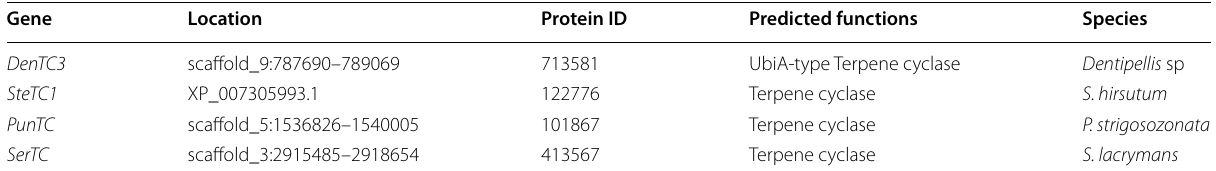
Table 3 Four basidiomycete genes that can produce di-TPS in S. cerevisiae Gene Location Protein ID